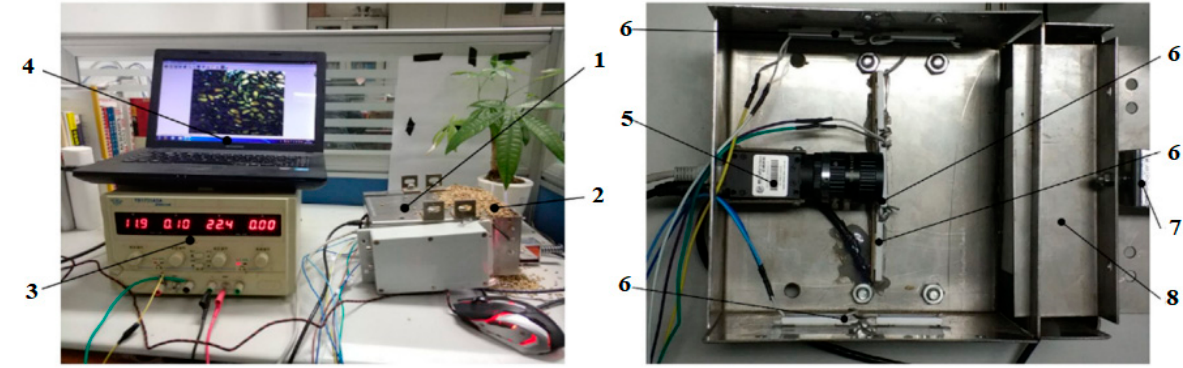
Figure 19. Installation of the experimental system. 1—sampling box, 2—rice grain, 3—stabilized voltage source, 4—PC, 5—CMOS camera, 6—LEDs, 7—electromagnet, 8—choke plate [55].